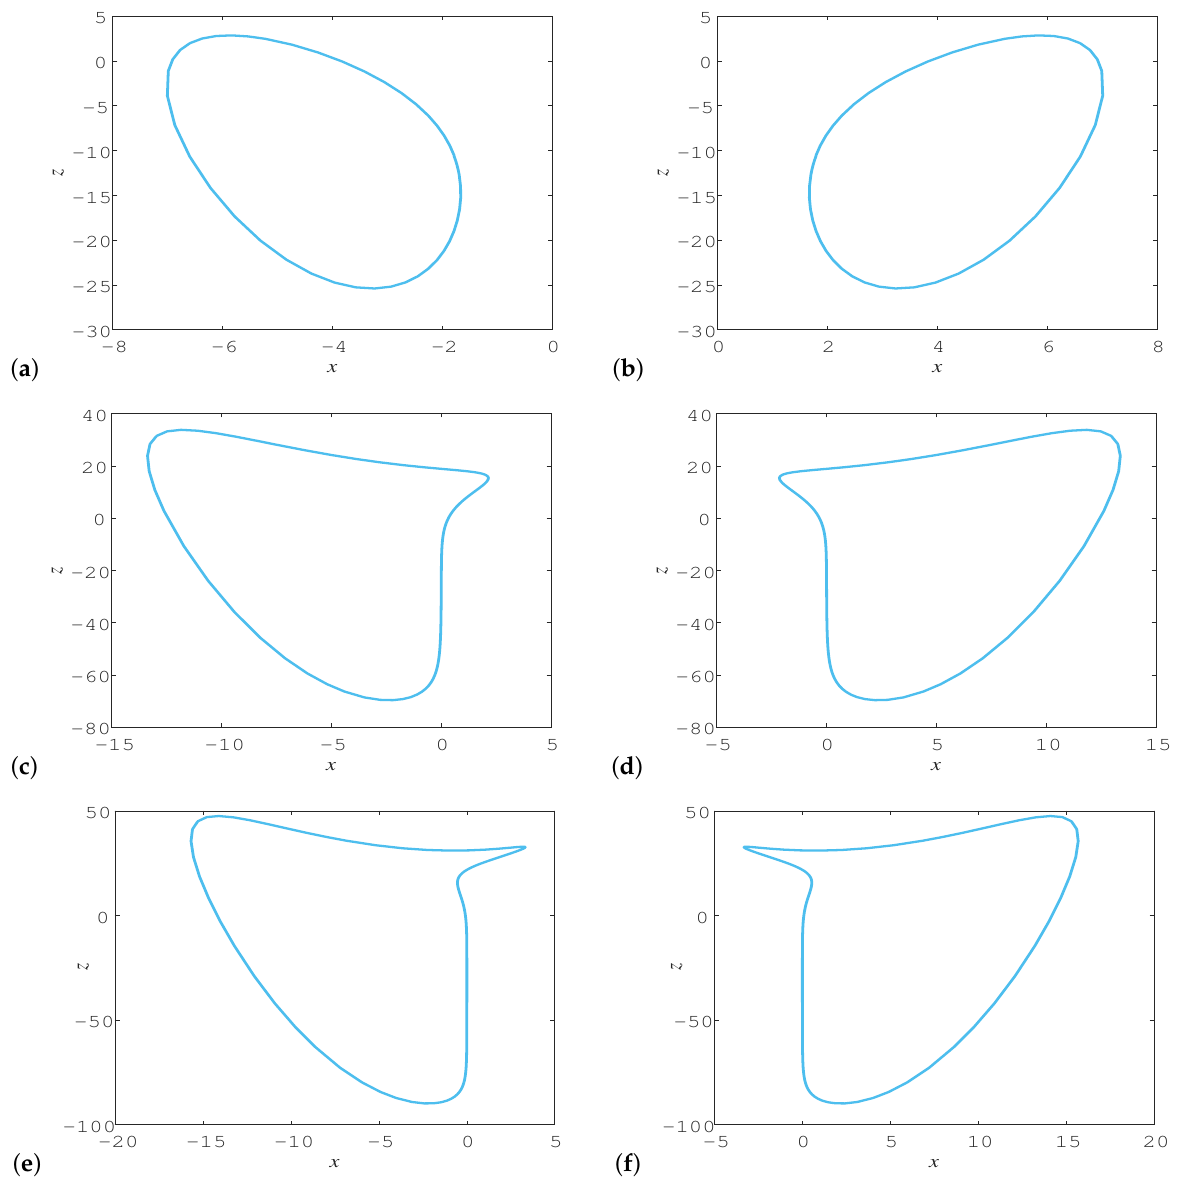
Figure 14. Six building block cycles for system (2), ( a , b , c , k ) = ( 12,100,10,4.6 ) : ( a ) cycle 0, ( b ) cycle 1, ( c ) cycle 2, ( d ) cycle 3, ( e ) cycle 4, and ( f ) cycle